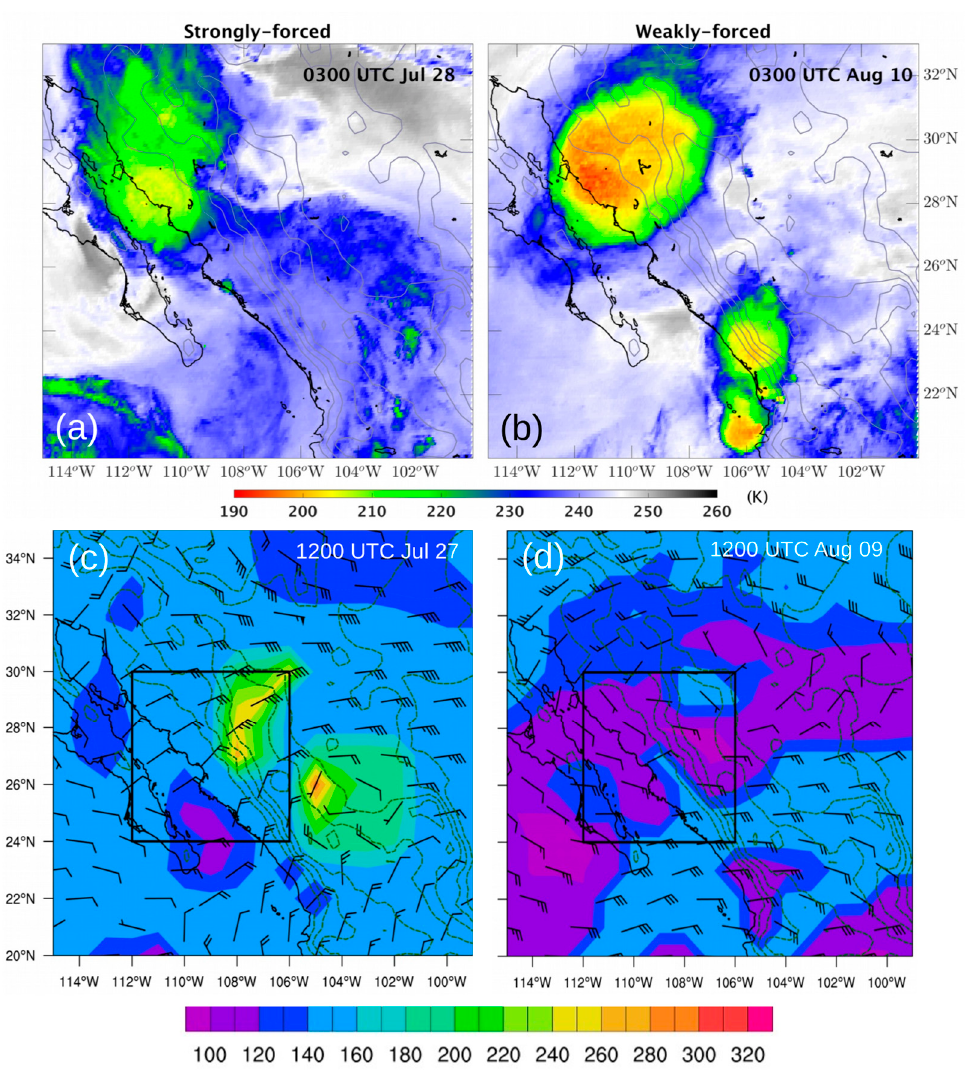
Figure 9. Images from GOES 15 WV are displayed on panels ( a ) and ( b ). The extent of the cloud top exceeds 100 km, and regions with temperatures less than 210 K indicate the highest points of the cloud top in the atmosphere. The pressure at 2-PVU (dynamic tropopause) and winds at 300 hPa layers taken from GFS Analysis valid at 1200 UTC are displayed on panels ( c ) and ( d ). The box indicates the monsoon core region set up by NAME 2004. Note that on the strongly forced day, the IV is characterized by the cyclonic turning of the winds and the PV anomaly at 240 to 260 hPa region inside the box.